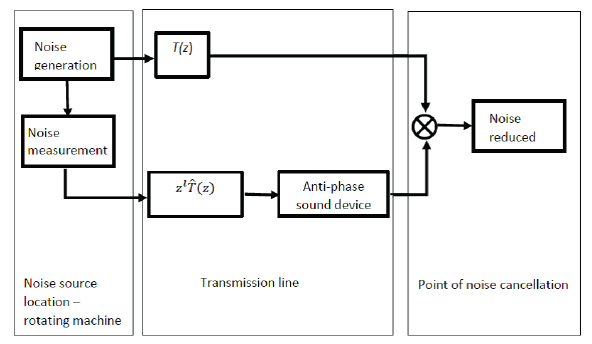
Fig. 4: Feedforward noise